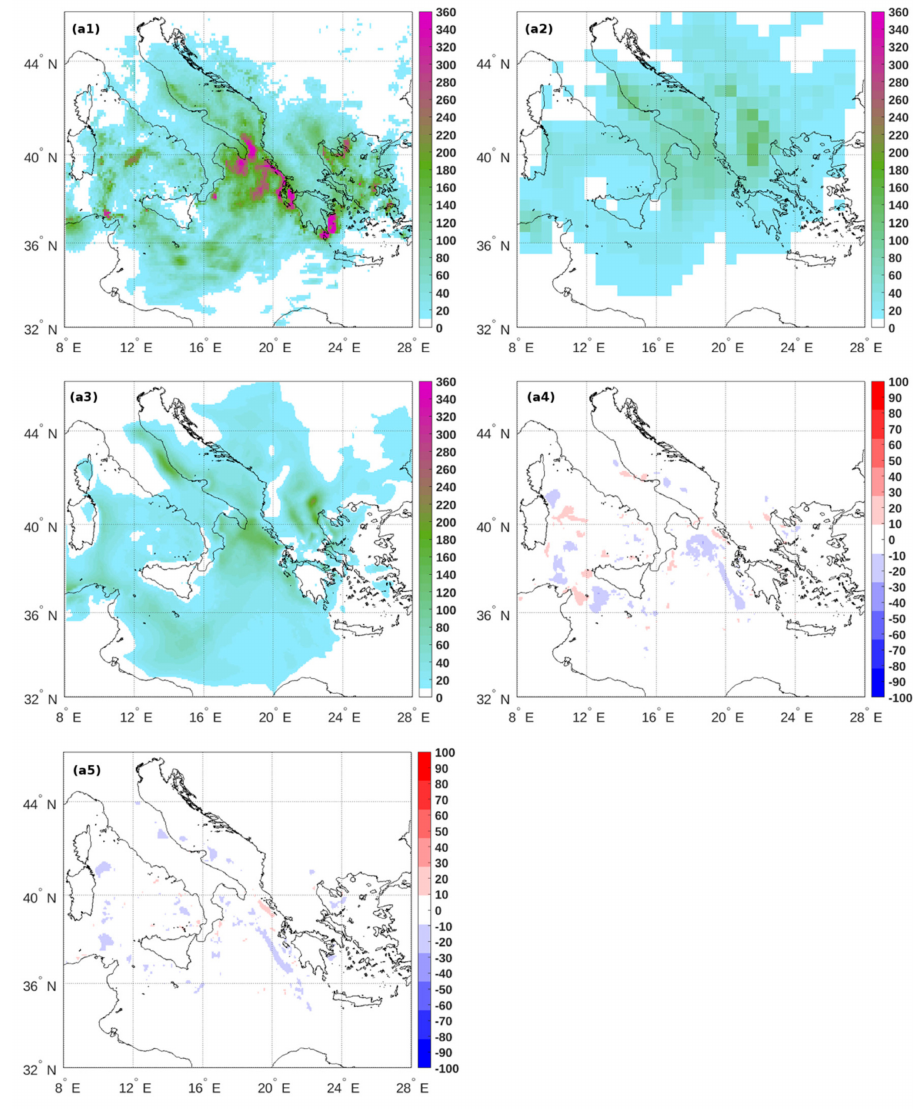
Figure 16. ( a1 ) Accumulated precipitation fields in millimeters from IMERG satellite data, ( a2 ) accumulated precipitation field in millimeters from MERRA-2 reanalysis, ( a3 ) accumulated precipitation field in millimeters from RTG-sst run ( a4 ) di ff erences in accumulated precipitation fields between NEMO-sst and RTG-sst, and ( a5 ) di ff erences in accumulated precipitation fields between OSTIA-sst and RTG-sst, for cyclone